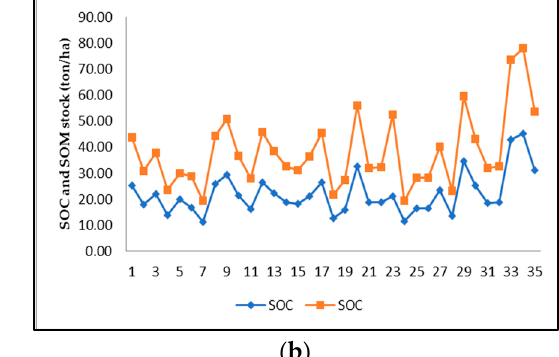
Figure 3. Between plot variations in SOC and SOM; ( a ) concentration (%), ( b ) stock (ton/ha). Blue lines indicate SOC, and yellow lines indicate SOM.